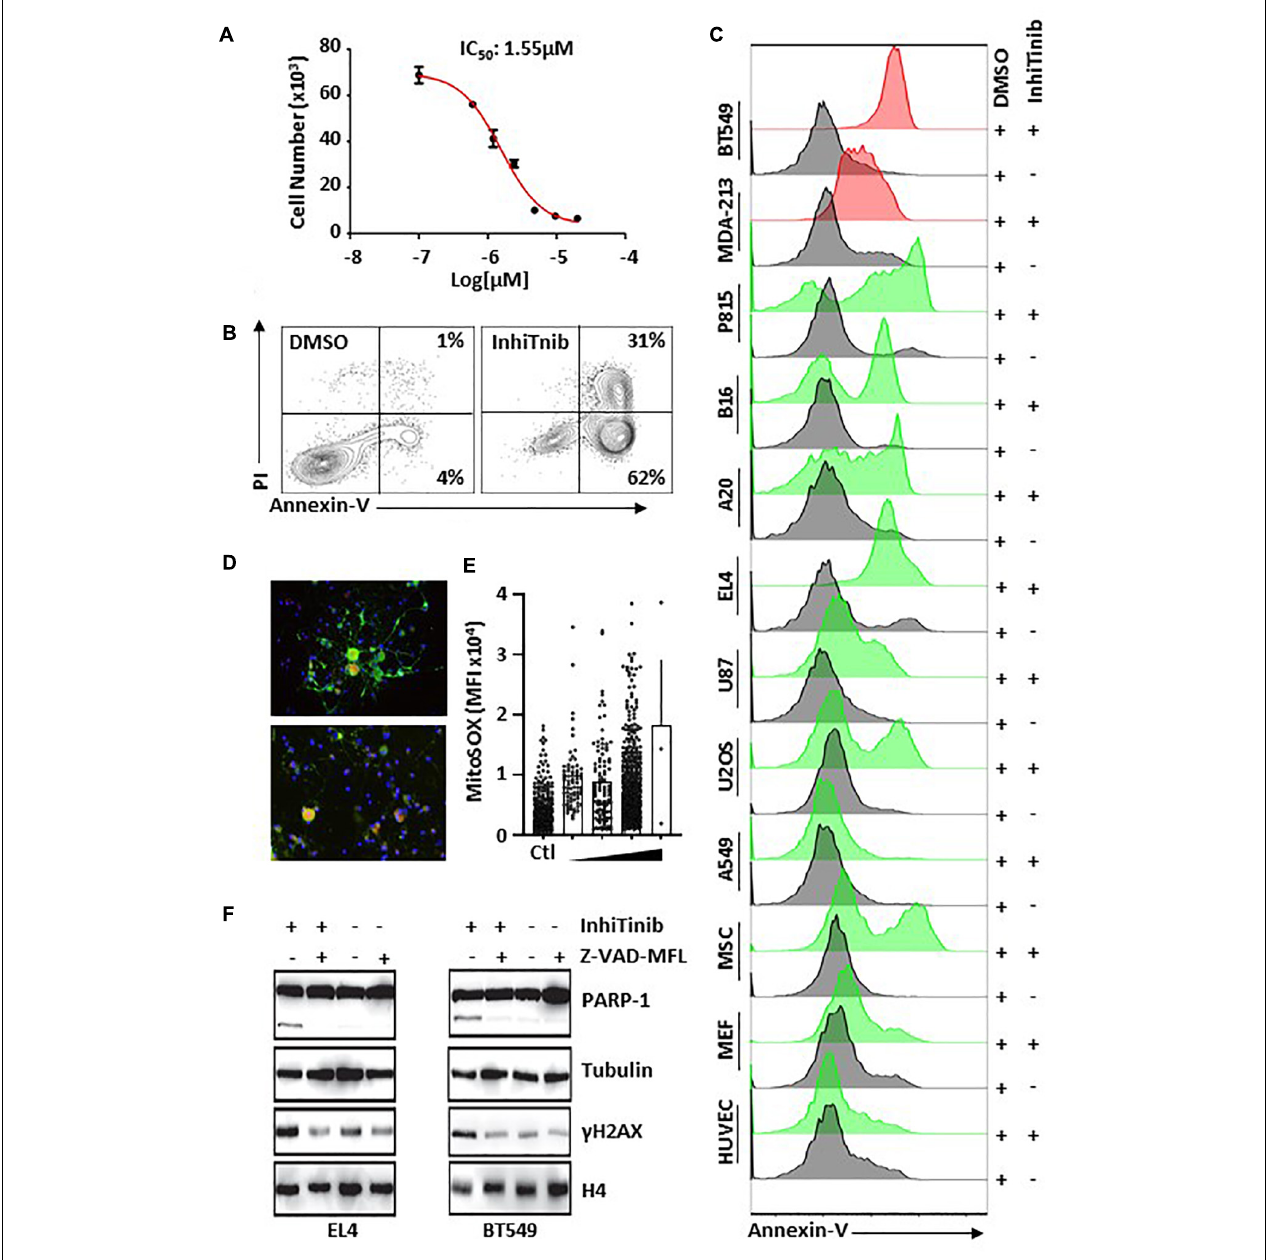
FIGURE 2 | Characterizing the pro-apoptotic properties of InhiTinib on cancer cells. (A) Identification of the IC 50 dose for InhiTinib using a proliferation assay conducted on the EL4 lymphoma cell line ( n = 5/group). (B) Representative flow-cytometry analysis of Annexin-V/PI positive EL4 cells in response to InhiTinib treatment at 3.10 µ M (IC 100 ) or equivalent volume of DMSO. (C) Representative flow-cytometry assessment of Annexin-V on various cancer and primary cells treated with the EL4-specific IC 100 dose identified for InhiTinib. Cell lines represented by red histograms have a mutated p53 . (D) Pictograms depicting ROS levels (in red) using TUBB3 + dorsal root ganglion neuros (in green) following an overnight treatment with InhiTinib at 3.1 µ M. (E) MFI quantification of ROS by microscopy. (F) Representative western-blot evaluating the activation of PARP-1 and γ H2AX induction. Z-VAD-MFL was used to inhibit caspase activation. For illustrative purposes, blot images were cropped. A full scan of the original gels is found among Supplementary Material